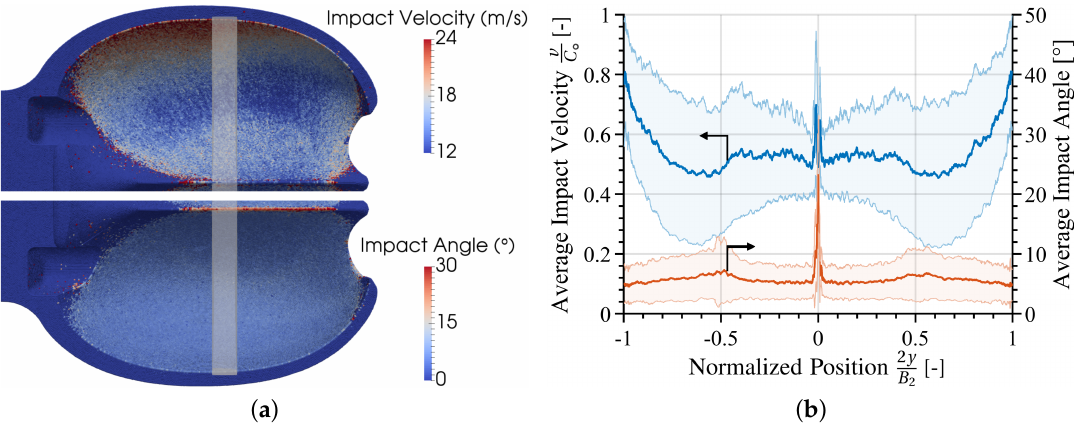
Figure 3. Average sediment impact velocity and angle distributions on the bucket surface ( a ) and on the pitch diameter position ( b ). The values presented in ( b ) are taken from the rectangular stripe illustrated in ( a ); the shaded region represents ± one standard